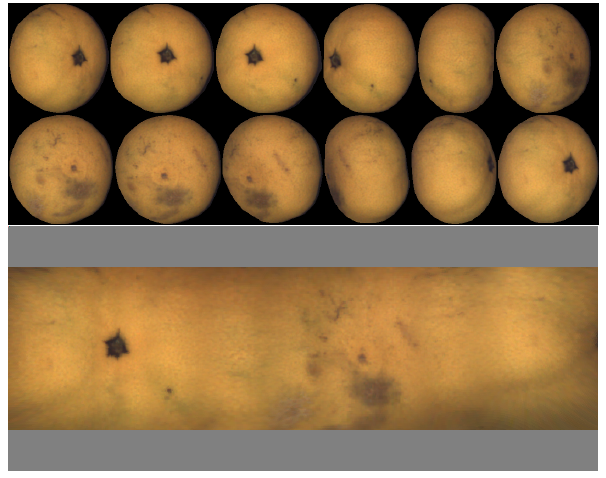
Figure 2. Set of views and resulting